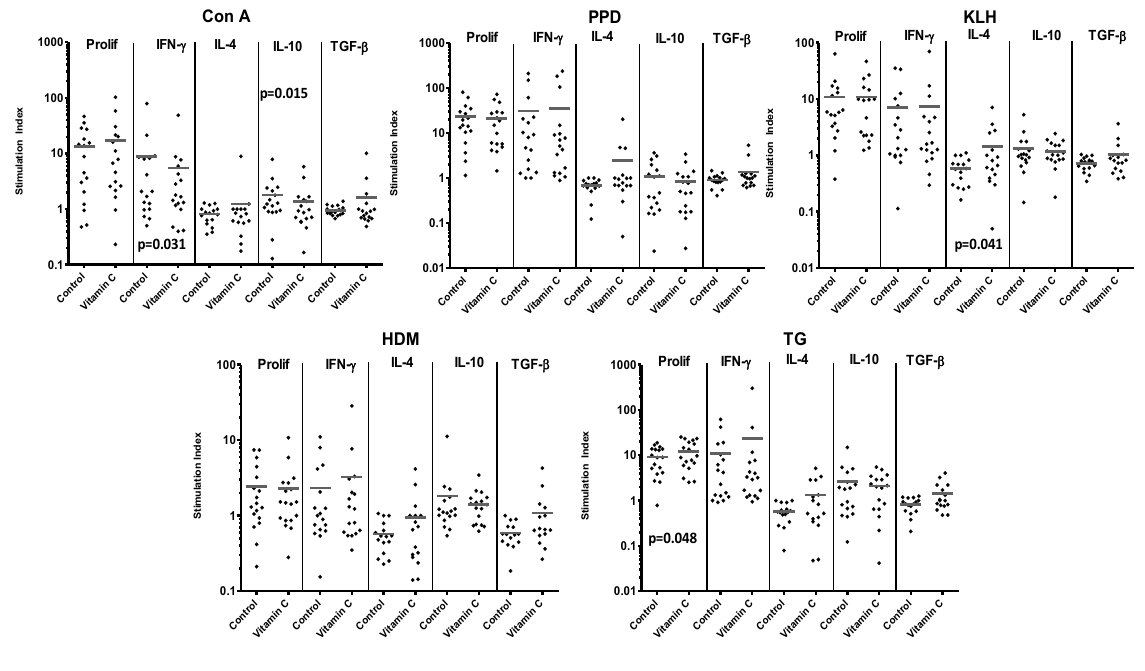
Figure 4. Responses of 18 PBMC samples to control stimuli and allergens, with or without supplementation with vitamin C. Reponses are expressed as stimulation index. Bars represent mean stimulation indices for each set of culture conditions. Significant p values for differences in responses between paired samples in cultures with or without vitamin C supplementation are shown on the relevant